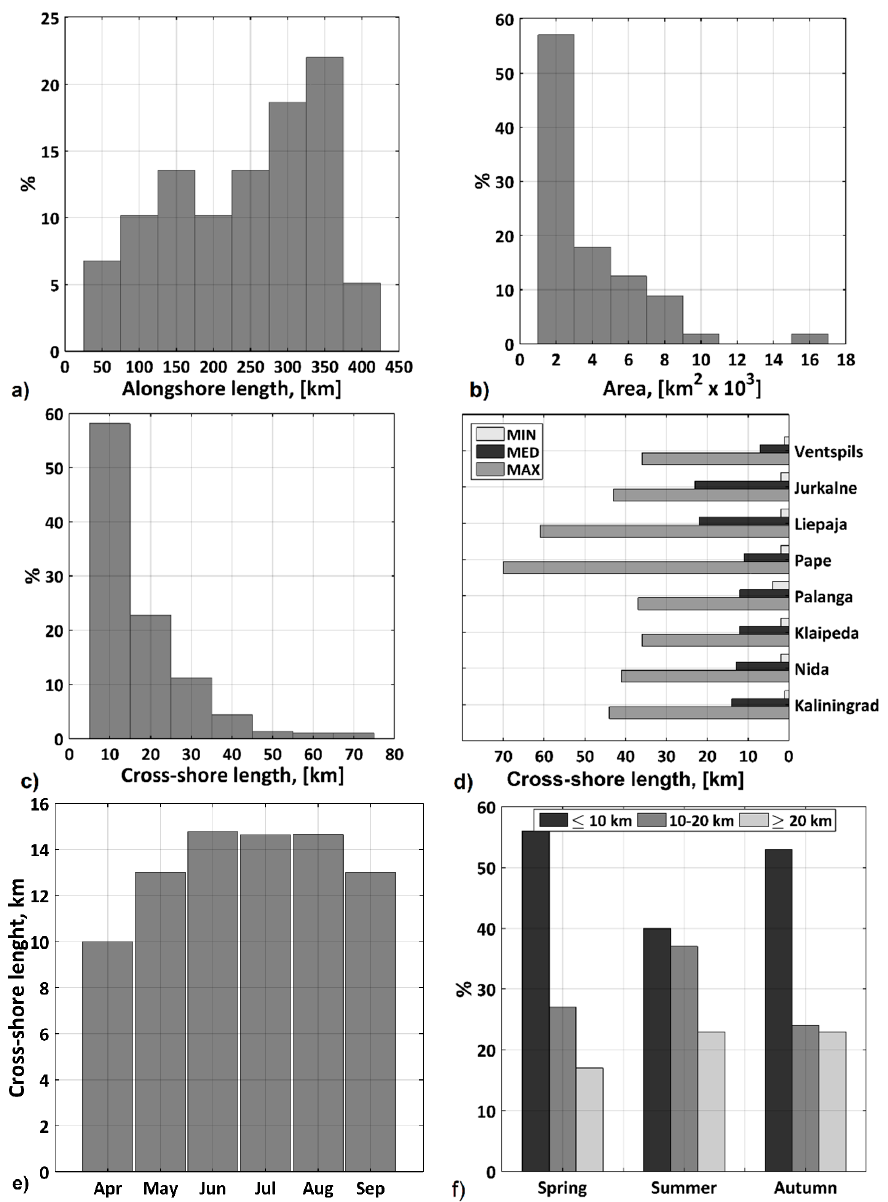
Figure 9. Spatial properties of coastal upwelling front in the SE Baltic Sea. Histogram distributions of ( a ) along-shore length; ( b ) upwelling area; ( c ) cross-shore length; ( d ) spatial distribution of cross-shore length; ( e ) monthly-mean cross-shore length; and ( f ) seasonal variation of cross-shore